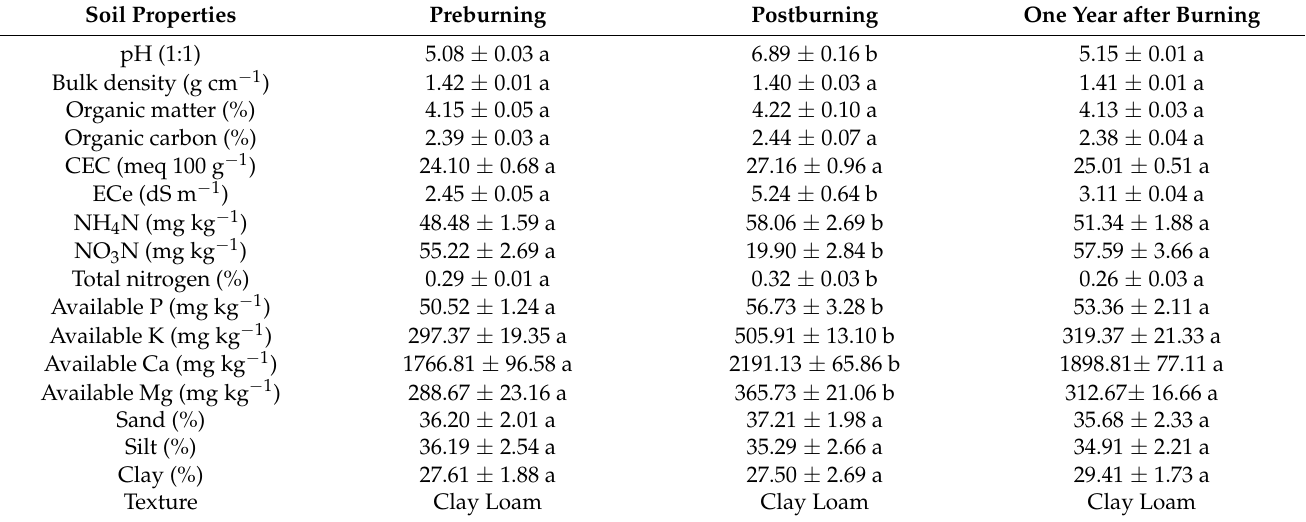
Table 2. Physicochemical properties of paddy soil samples before burning, after burning, and 1 year after